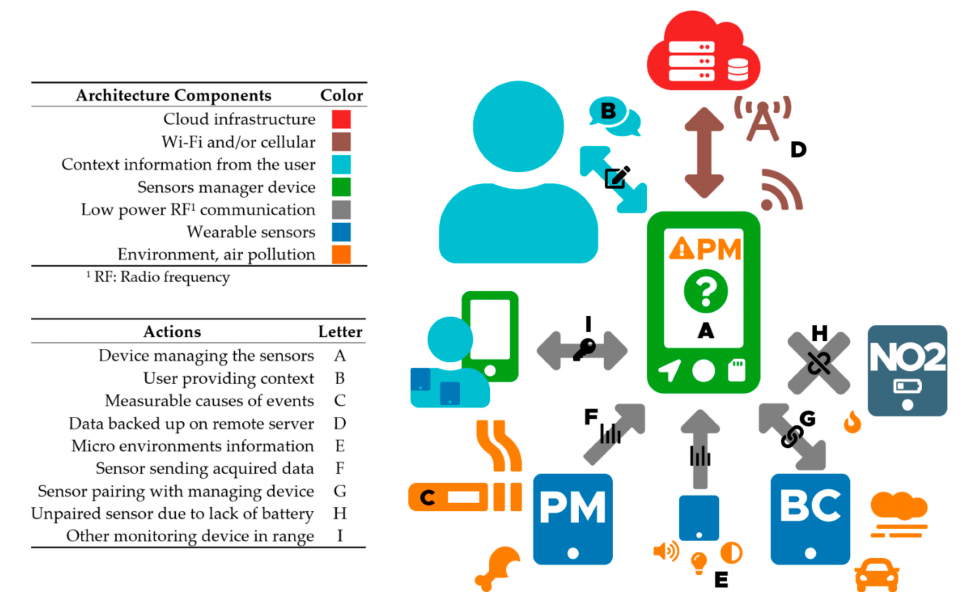
Figure 11. Illustration of the air pollution sensors mesh